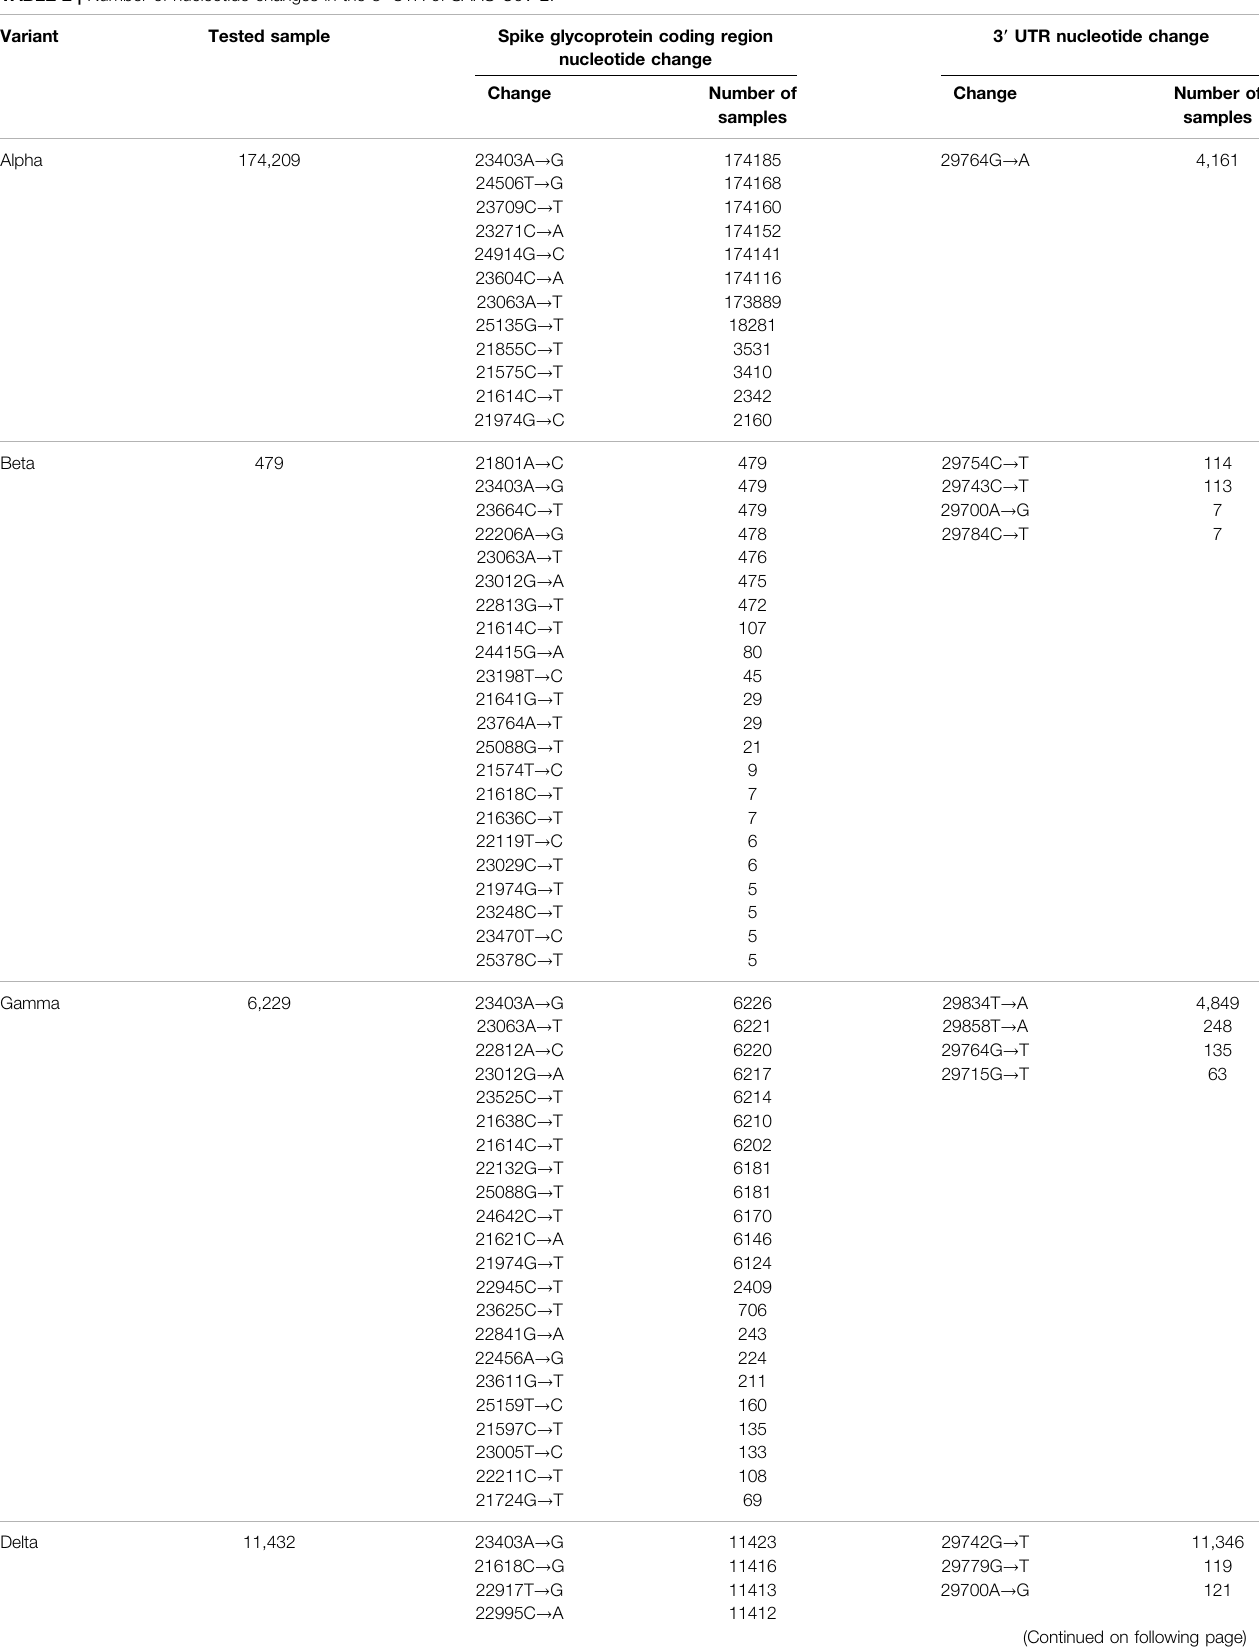
TABLE 2 | Number of nucleotide changes in the 3 ′ UTR of